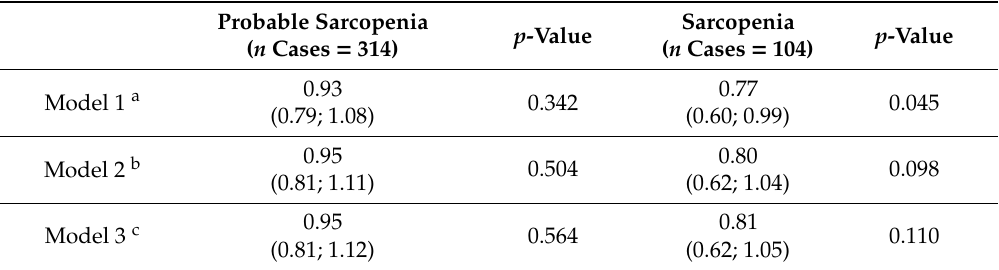
Table 4. Associations between Ferric Reducing Ability of Plasma (FRAP) score and prevalence of (probable)